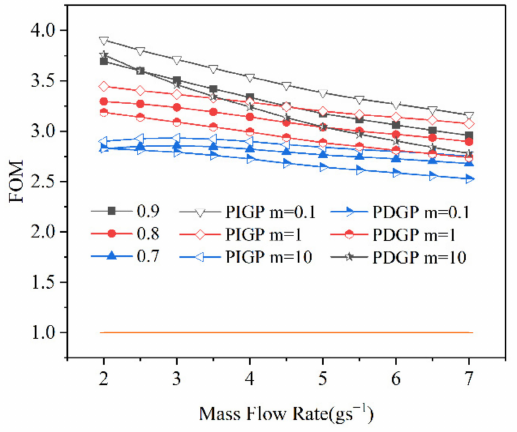
Figure 15. FOM versus mass flow rate (with AFHS with gradient porosity designed in the Z -axis direction).